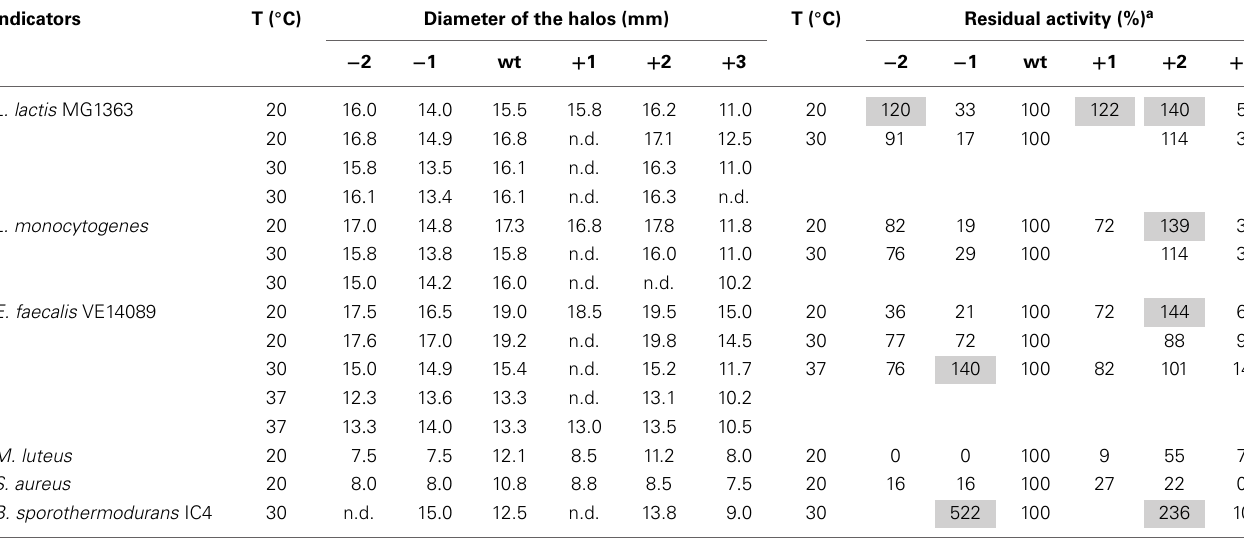
Table 5 | Activities of the hinge region analogs in agar well diffusion assay. Indicators